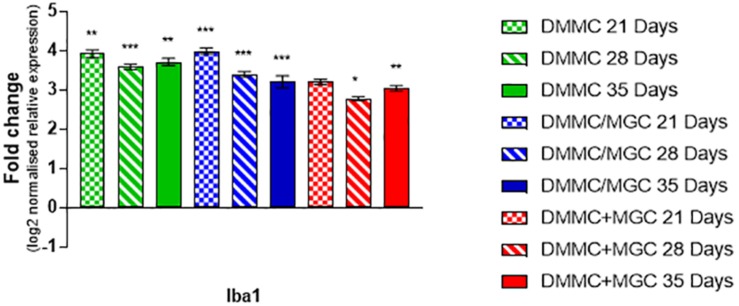
Comparisons of Iba1 gene expression relative to healthy adult mouse brain extract. Statistical comparisons relative to reference brain extract shown on graph only (n = 3, ∗p < 0.05, ∗∗p < 0.01, ∗∗∗p < 0.001).